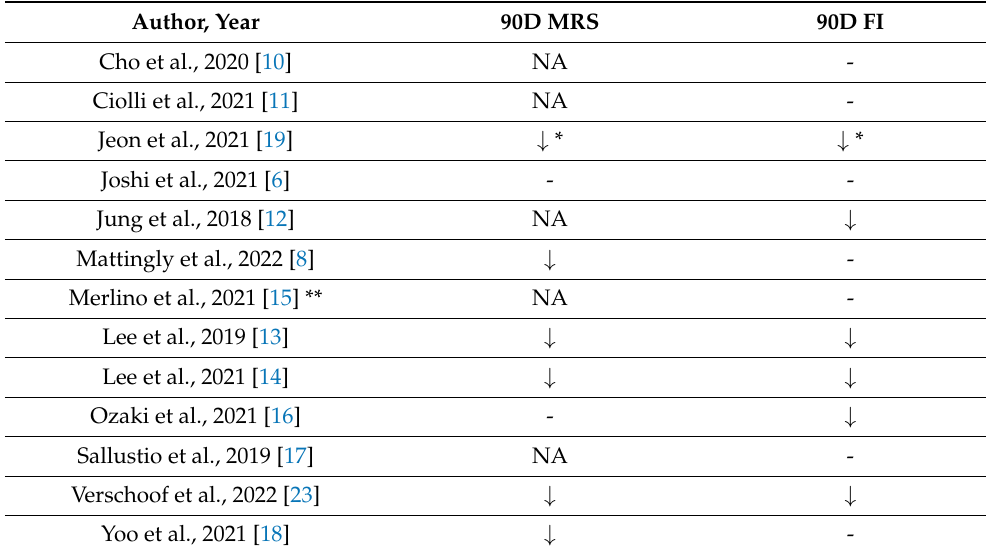
Table 5. Overview of 90-daymRS scores and functional independence tendencies in cancer patients compared to non-cancer